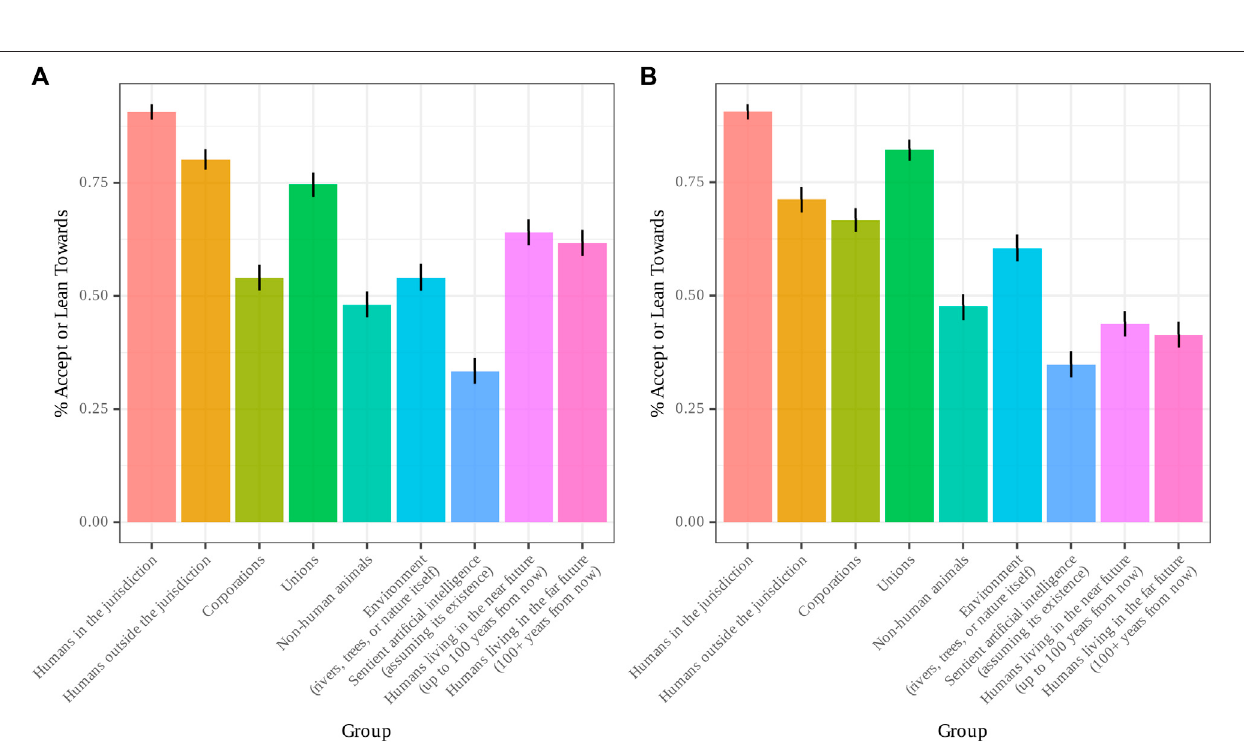
FIGURE 2 | %Endrosement of (A) personhood and (B) standing for sentient Al and other groups.